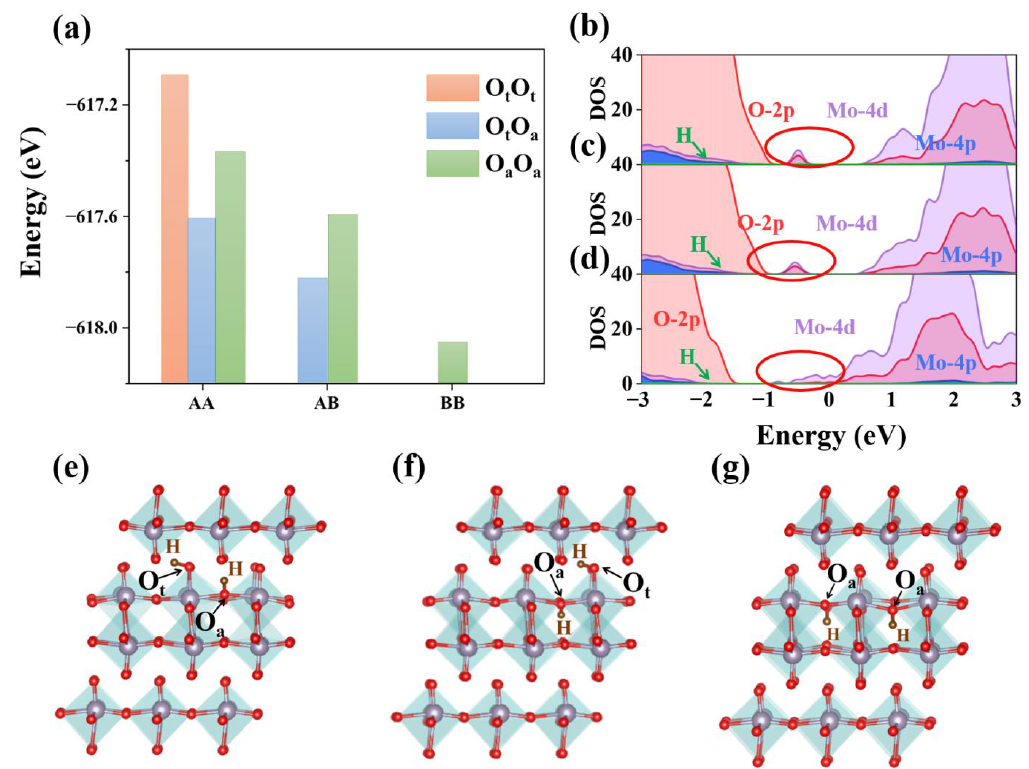
Figure 4. ( a ) Energy diagram of three systems. ( b ) Density of states of AA site. ( c ) Density of states of AB site. ( d ) Density of states of BB site. ( e ) AA site bonding structure. ( f ) AB site bonding structure. ( g ) BB site bonding structure.